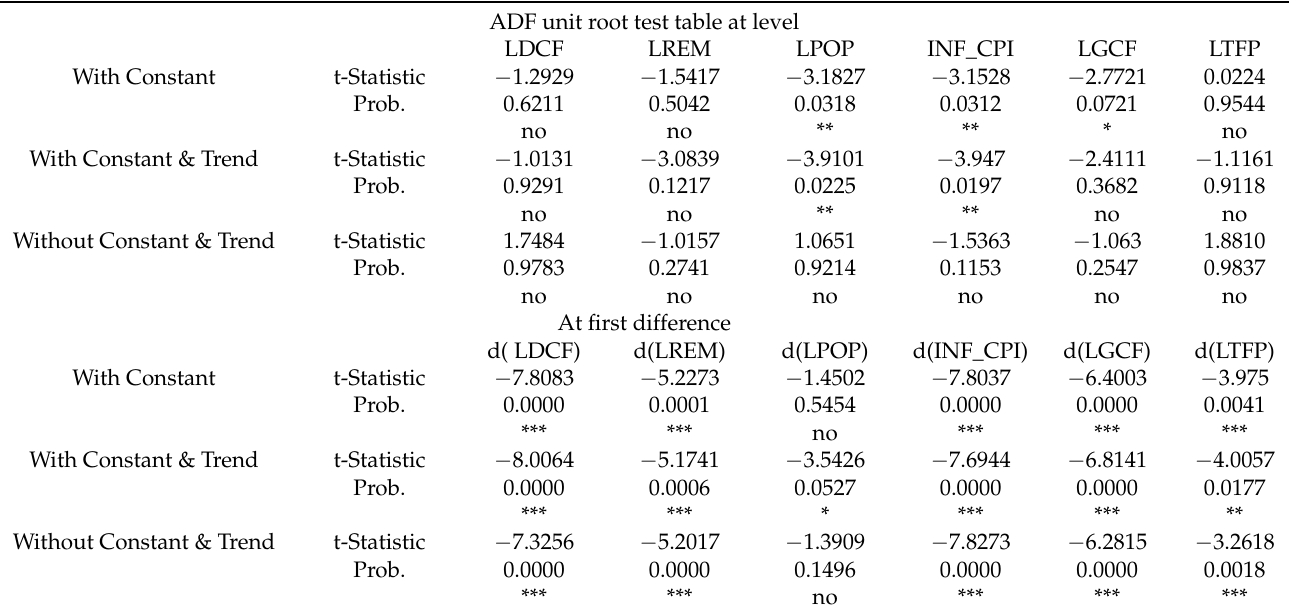
Table A3. Unit root ADF test at level and first difference.